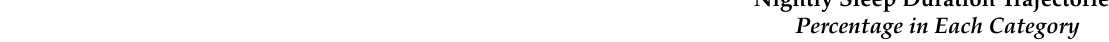
Table 2. Eating behaviors at age 2 by to trajectories of nightly sleep duration over childhood; 559 children enrolled in Center for Oral Health Research in Appalachia Cohort 2 between 2012 and 2018, with sleep data followed from age 2 years to age 5.5